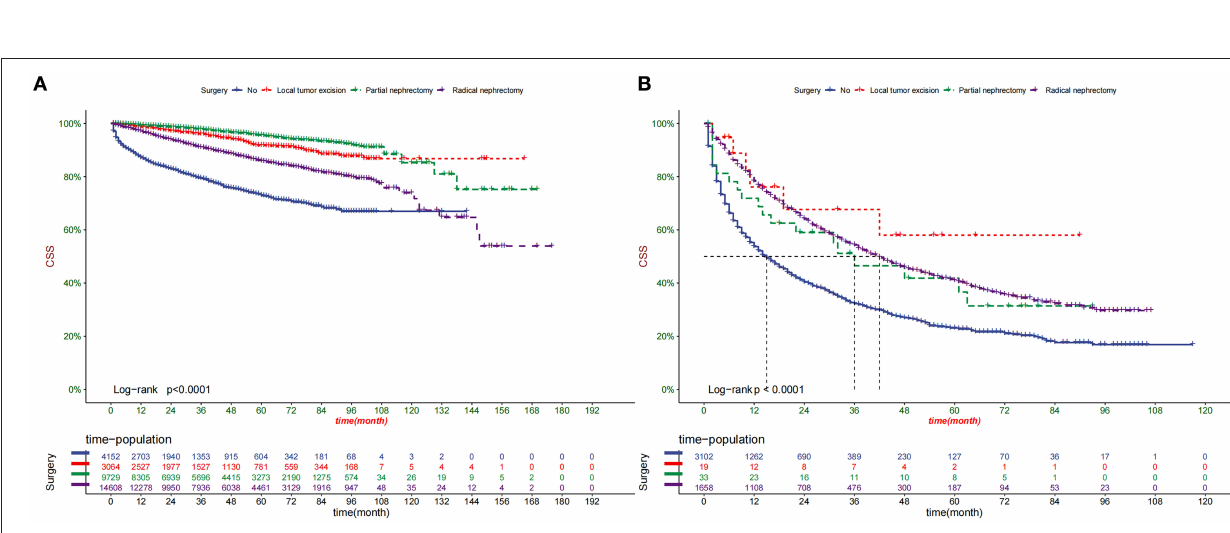
Frontiers in Public Health |